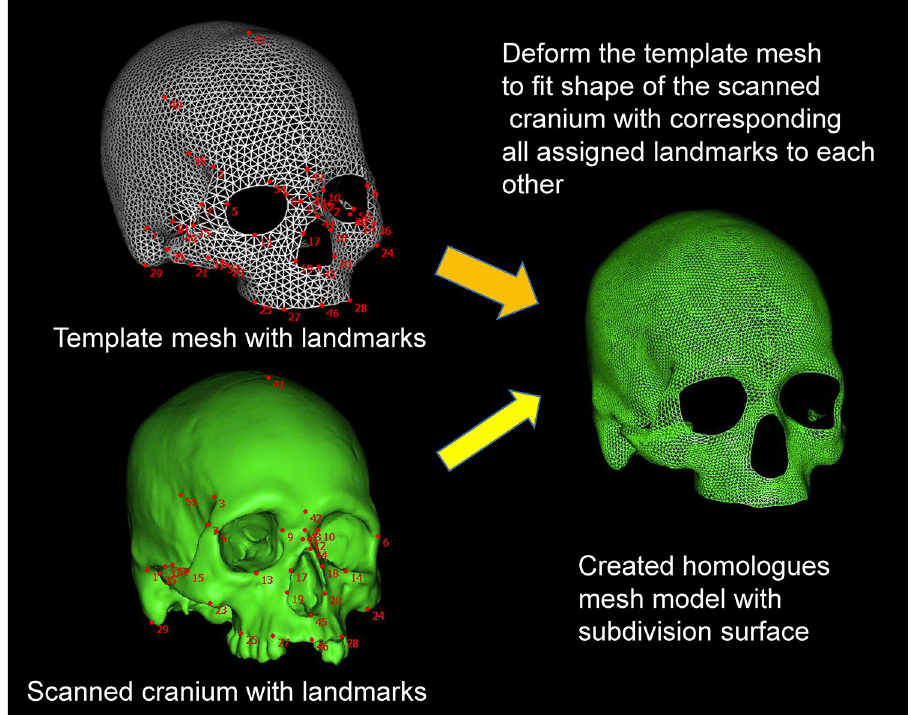
Figure 1. Creation process of the homologous fitting model of 3D scanned